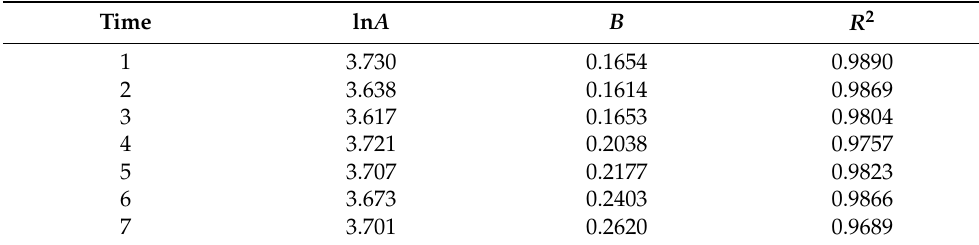
Table 2. Regression constants for Equation (4) during continuous